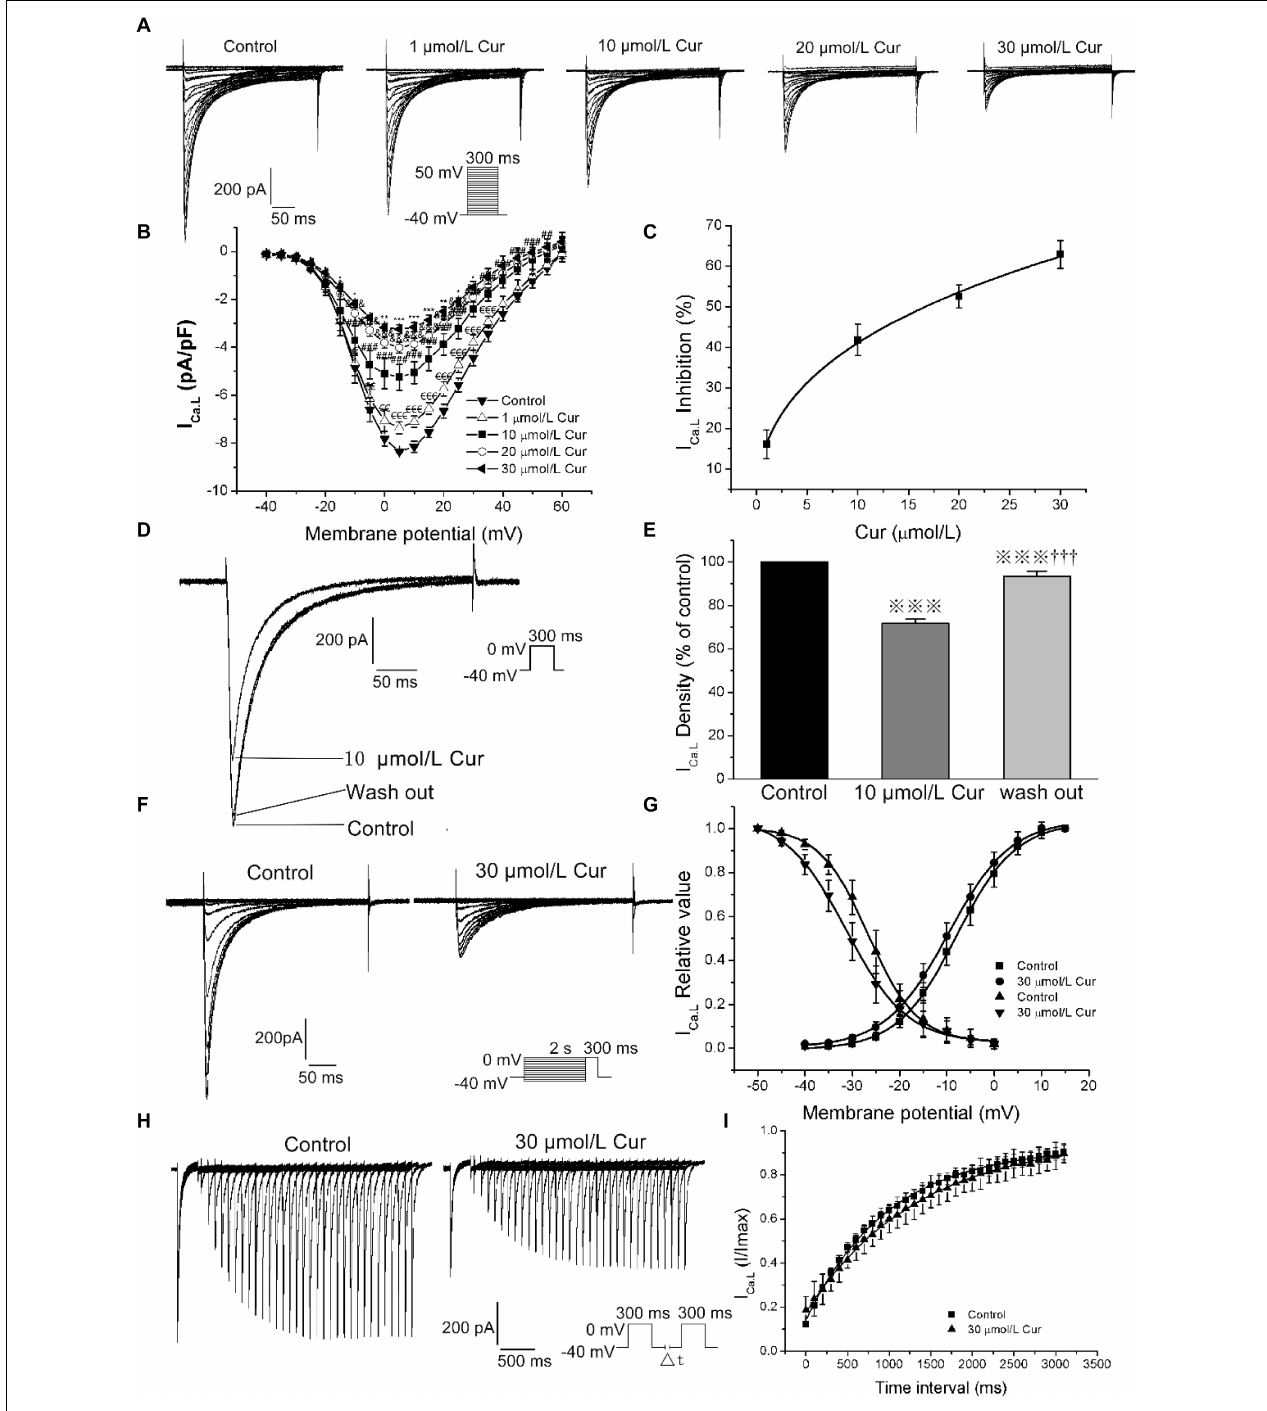
FIGURE 2 | The effects of Cur on L-type calcium current ( I Ca . L ) in ventricular myocytes. (A) Example records I Ca . L in different membrane potentials for the control group and Cur (5, 10, 20, and 30 µ mol/L) groups. (B) The current–voltage ( I – V ) relationship curves of Cur on I Ca . L ( n = 8, £ P < 0.05, ££ P < 0.01, £££ P < 0.001 vs. control; # P < 0.05, ## P < 0.01, ### P < 0.001 vs. 5 µ mol/L; & P < 0.05, && P < 0.01, &&& P < 0.001 vs. 10 µ mol/L; * P < 0.05, ** P < 0.01, *** P < 0.001 vs. 20 µ mol/L). (C) The concentration–response relationship curve of Cur on I Ca . L . (D) Example records of the single I Ca . L from the same cell of three groups (control group, 10 µ mol/L Cur group and wash out group), showing a reversible inhibitory effect of Cur on I Ca . L . (E) The comparison of average I Ca . L percentage values of the three groups ( n = 6, P < 0.001 vs. control; ††† P < 0.001 vs. 10 µ mol/L Cur). (F) Example records of steady-state inactivation of I Ca . L before and after administrating 30 µ mol/L Cur. (G) Steady-state activation and inactivation curves of two groups. (H) Example records of time-dependent recovery of I µ mol/L Ca . L before and after 30 Cur administration. (I) Time-dependent recovery curves of the two groups.